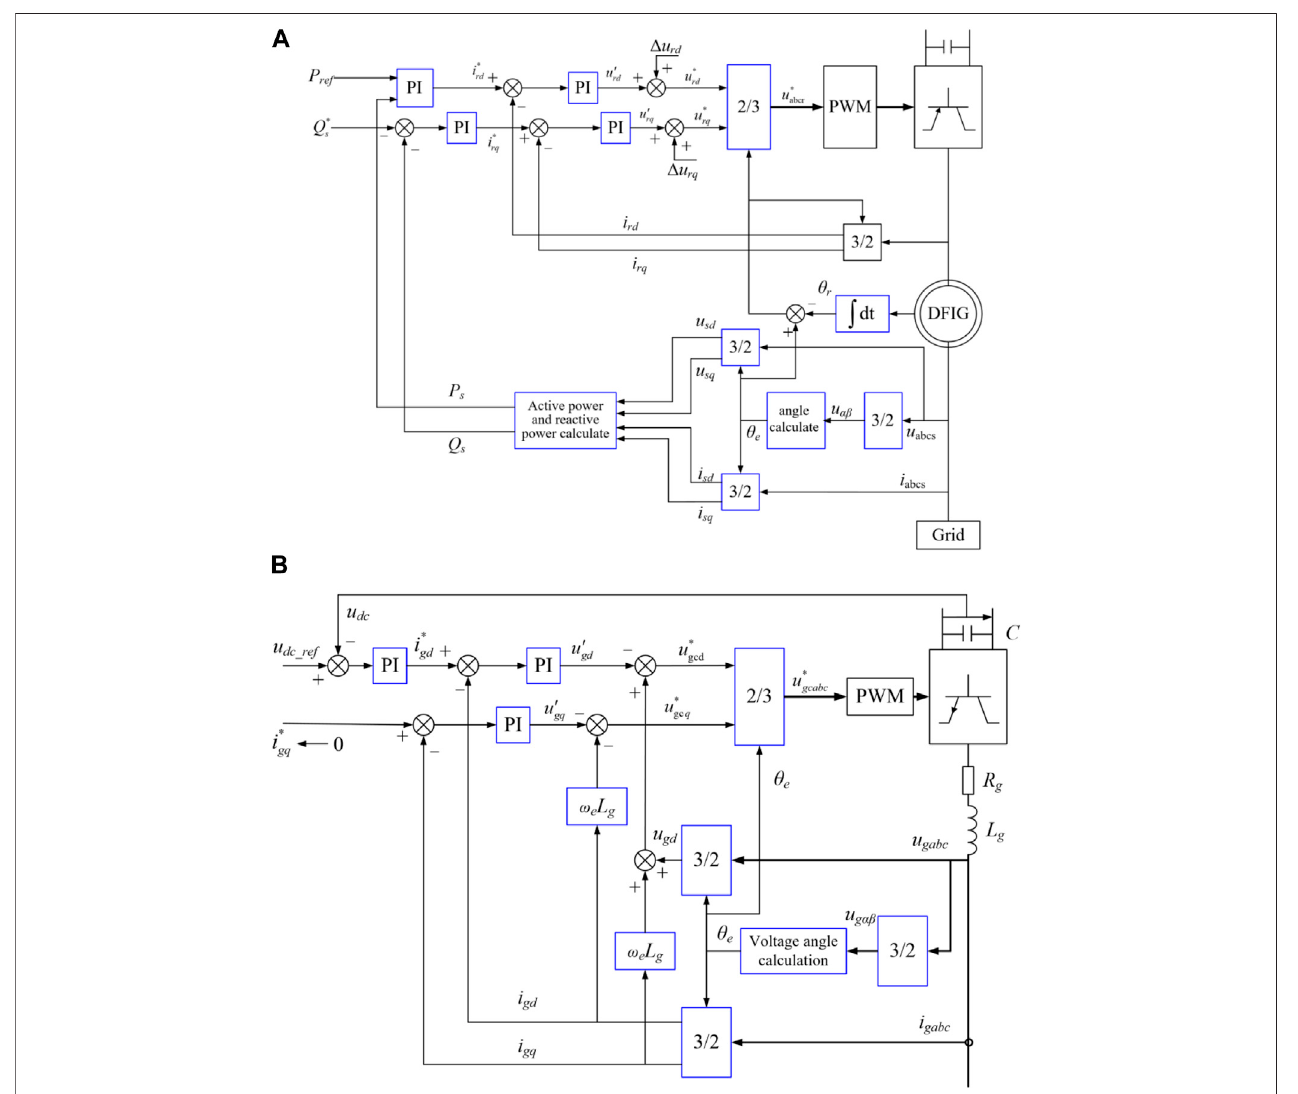
FIGURE 1 | Typical vector control scheme of the rotor side and grid side converters of a DFIG. (A) Vector control strategy of the rotor side converter. (B) Vector control strategy of the grid side converter.